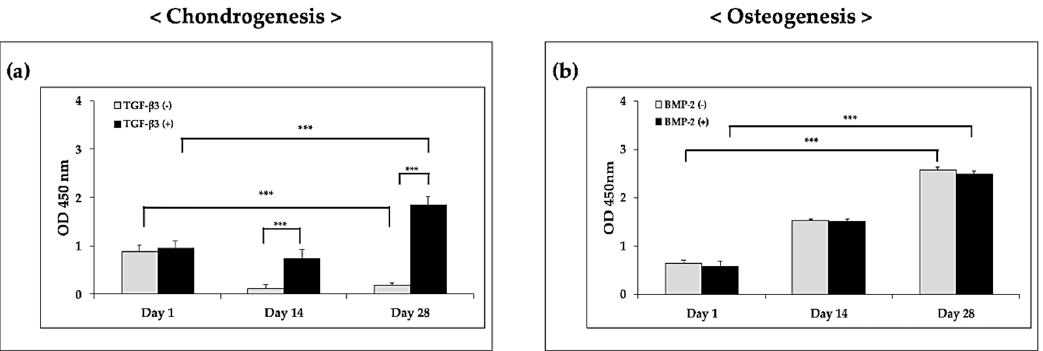
Figure 6. Proliferation results for ( a ) chondrogenesis and ( b ) osteogenesis on the hybrid scaffolds, as per the CCK-8 assays (OD = optical density). *** p < 0.001, two-way ANOVA with Tukey’s multiple comparison test.